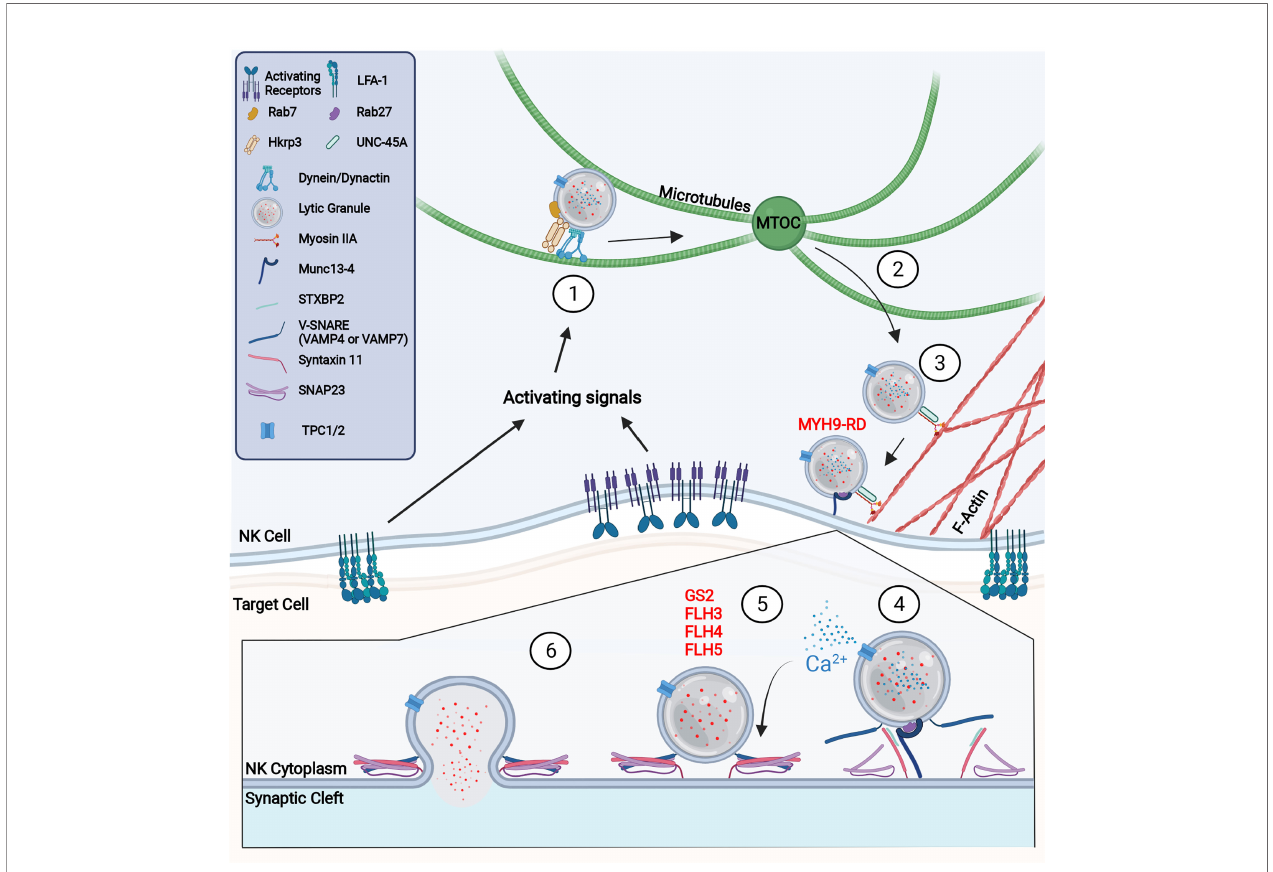
FIGURE 3 | Molecular process of NK cell degranulation (1) NK activating receptor and integrin signaling promotes LG convergence at the MTOC through the activity of the dynein/dynactin complex. (2) Upon further cell stimulation, the MTOC polarizes to the synapse where lytic granules are of fl oaded onto the F-actin network. (3) Traf fi cking along F-actin requires the activity of myosin IIA and UNC-45A. Defects in the myosin heavy chain, MYH9, prevents lytic granule penetration of the F-actin network and causes MYH9-related disease (MYH9-RD). (4) Upon reaching the membrane, Rab27a and Munc13-4 dock and tether lytic granules to the CS. Griscelli syndrome type 2 is caused by defects in Rab27a, which results in lytic granules accumulating at the membrane without docking. It is likely that at this step or at prior steps, the NAADP-mediated release of Ca2+ from the LG via TPC1 or TPC2 occurs to provide a local accumulation of calcium. Munc13-4 primes lytic granules for release through interaction with Syntaxin 11. (5) STXBP2 mediates formation of the SNARE complex, consisting of Syntaxin 11, SNAP23, and VAMP4 or VAMP7. Defects in Munc13-4, Syntaxin 11, and STXBP2 cause familial hemophagocytic lymphohistiocytosis (FHL) types 3, 4, and 5 respectively. (6) Successful formation of the SNARE complex creates a LG plasma membrane fusion pore through which degranulation